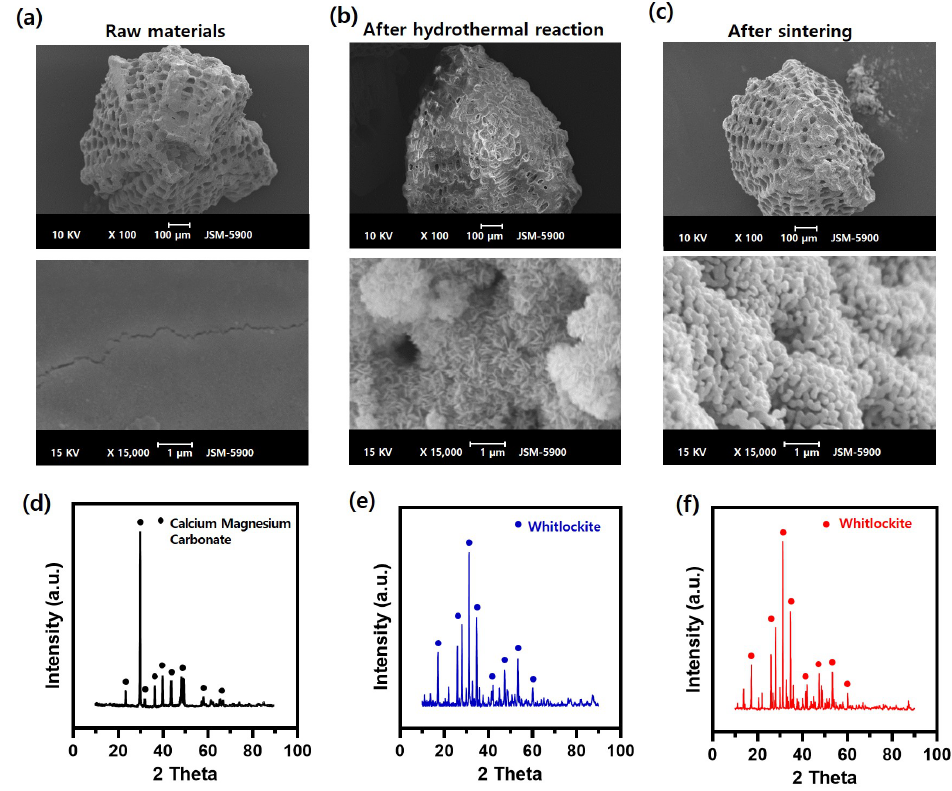
Figure 1. Surface morphology of marine-plankton-derived WH bone granules: ( a ) SEM images of the raw material, ( b ) material after the hydrothermal reaction, and ( c ) material after the sintering process. Characterization of the granules according to the process using XRD for the ( d ) raw material, ( e ) material after the hydrothermal reaction, and ( f ) material after the sintering process.